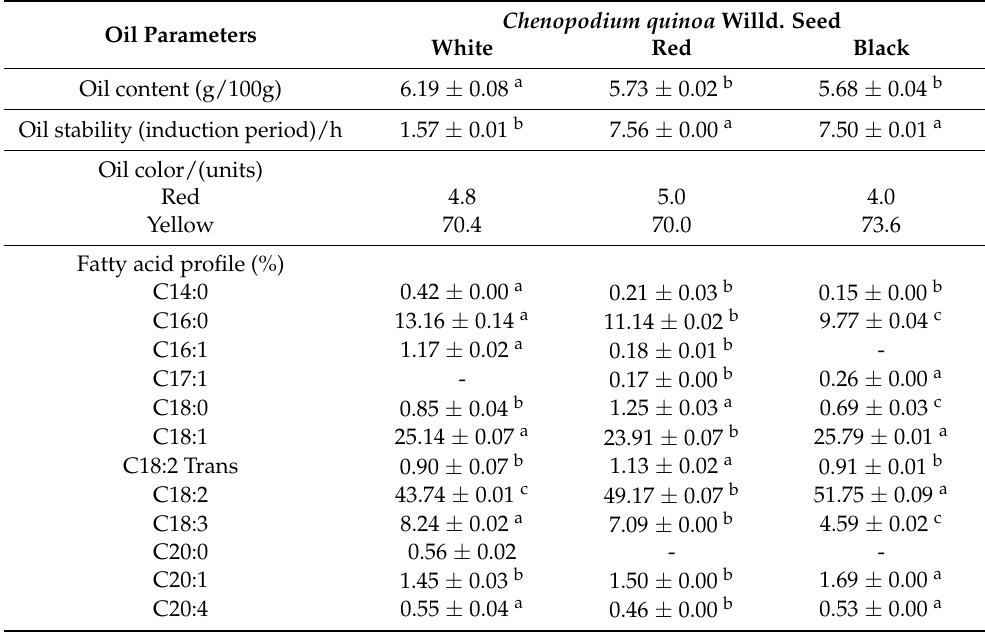
Table 1. Comparisons of physical and chemical characteristics of seed oils of three quinoa genotypes. Oil